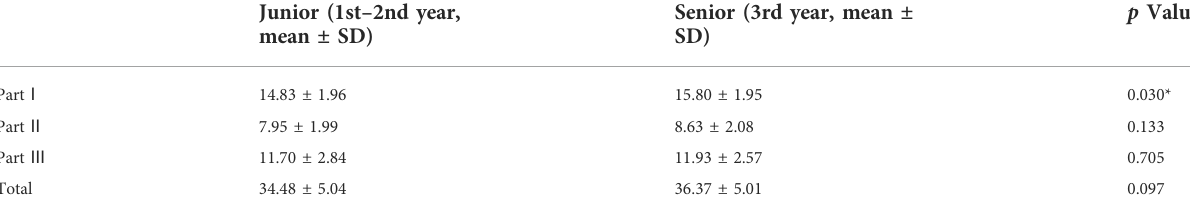
TABLE 4 Pre-lecture scores between junior and senior residents.